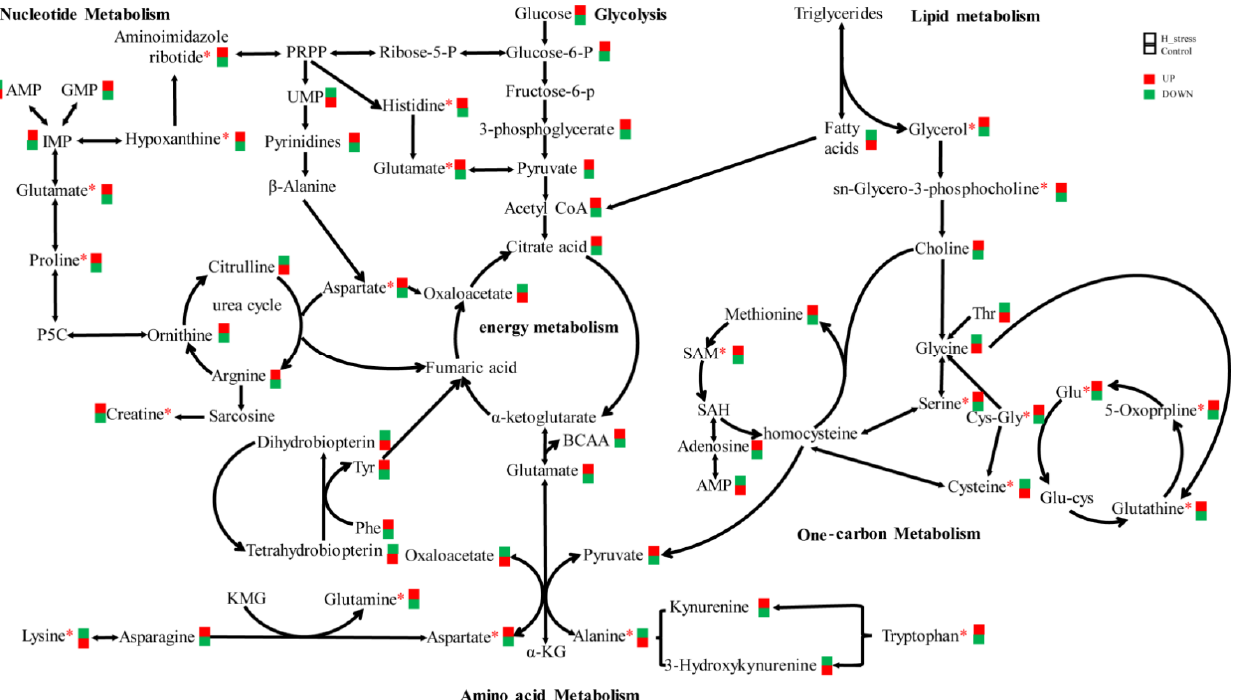
Figure 7. Intracellular metabolic network in the MAC-T bovine mammary epithelial cell line cultured at 42 °C for 12 h. The red boxes represents the higher concentration of the molecule and the green boxes represents the lower one. * p < 0.05.